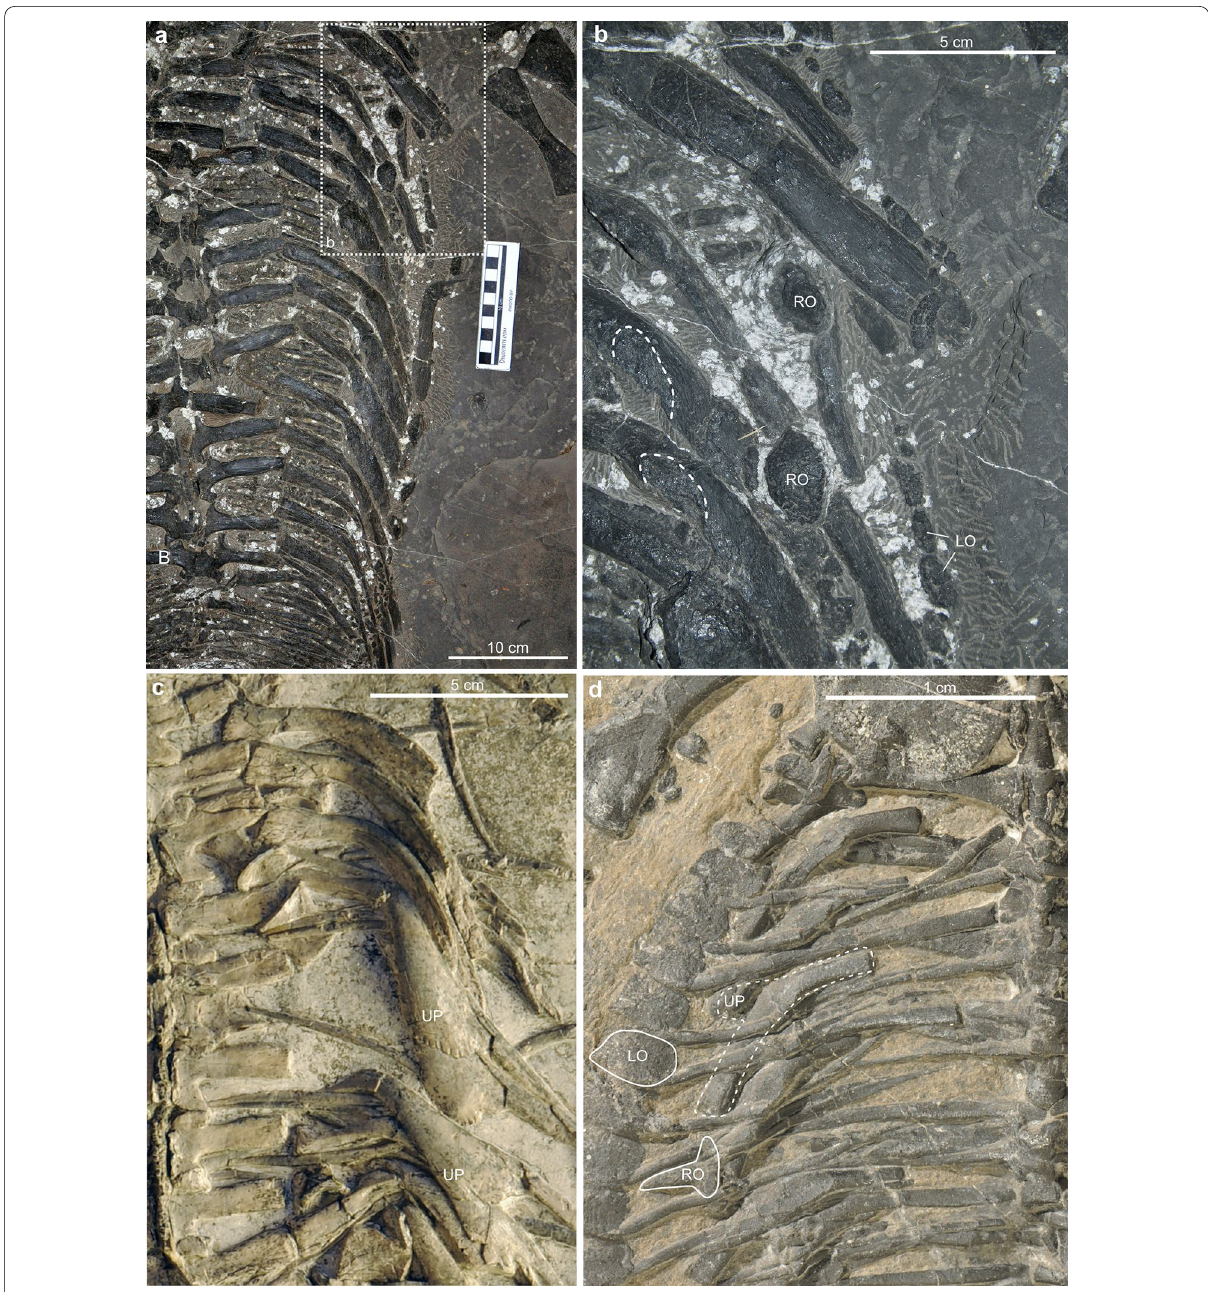
Fig. 3 Comparison of the thoracic regions of Largocephalosaurus qianensis (GMPKU‑P‑1532‑B; a and b ), Paraplacodus broilii (PIMUZ T 4287, c ), and Eusaurosphargis dalsassoi (PIMUZ A/III 4380, d ). a Right half of the rib cage in dorsal view. The rectangle indicates the position of the close‑up shown in b . b Close‑up of the anterior ribs and osteoderms. Note rugose and slightly depressed surfaces on the ribs’ uncinate processes (indicated by thin stippled lines), that resemble the position where the osteoderms were positioned in situ. c Close‑up of the anterior right thoracic ribs shown wide flaring uncinate processes with a smooth bone surface. d Rib with uncinate process and pylon‑shaped osteoderm. LO, lateral row osteoderm; RO, rib osteoderm; UP, uncinate